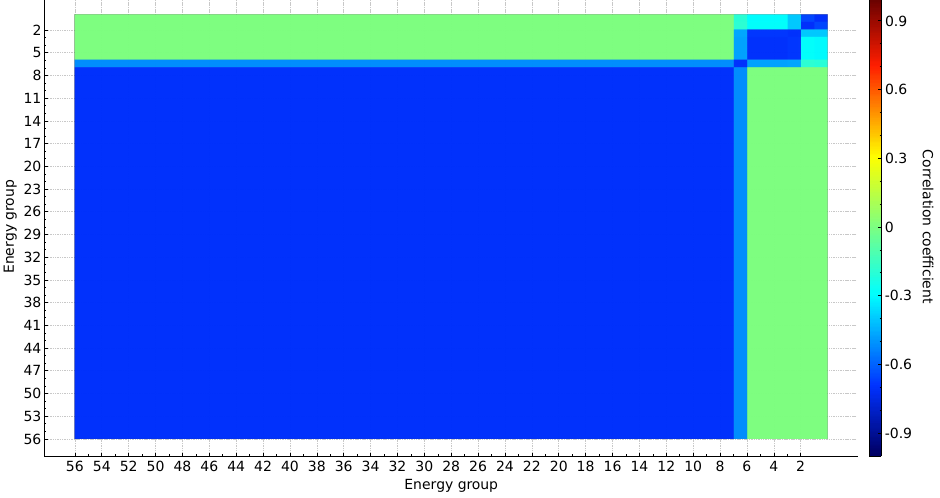
Figure 23. SCALE 56-group correlation matrix between 238 U ¯ ν p (MT = 456) and ¯ ν d (MT = 455). The functional 1D results over time for P max